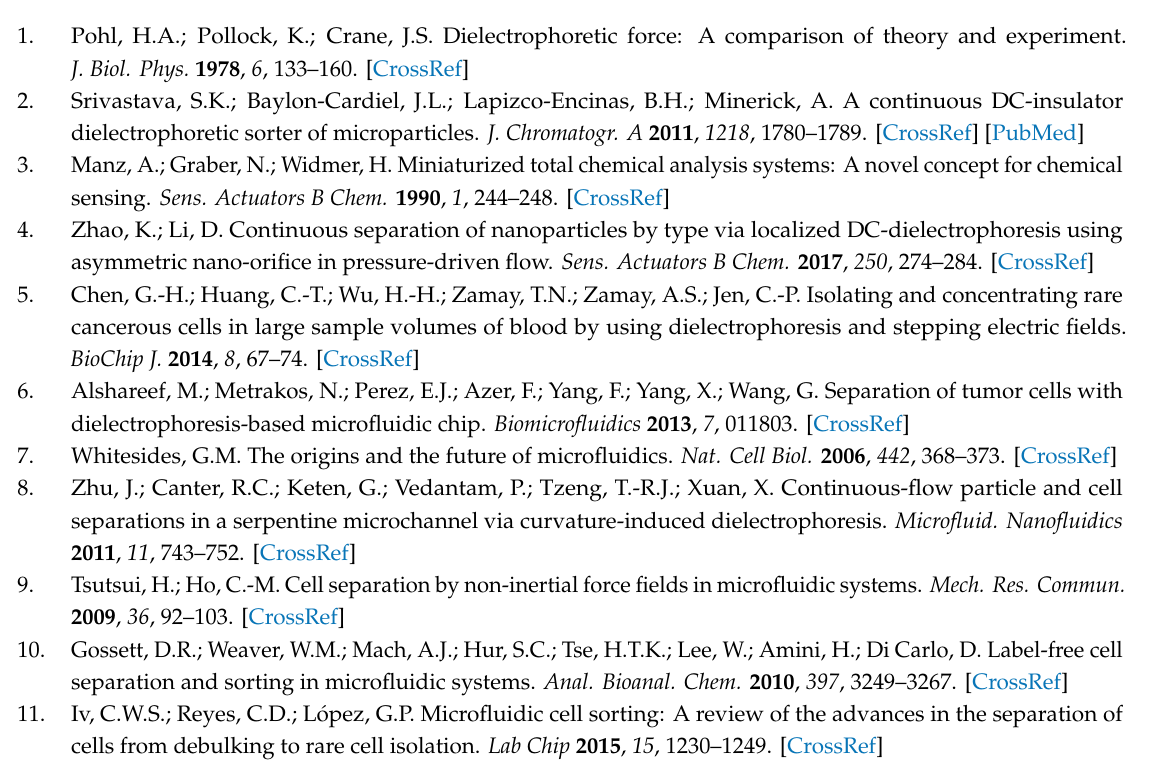
Figure S1: Cells under the microscope: (A) bright field; (B) green light; (C) blue light; and (D) ultraviolet light, Video S1: Particle collection in the first stage, Video S2: Particle collection in the second